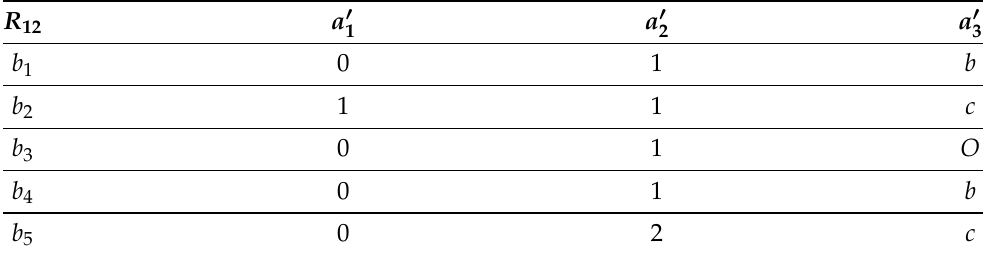
Table 3. Incidence relation R 12 corresponding to the bond γ